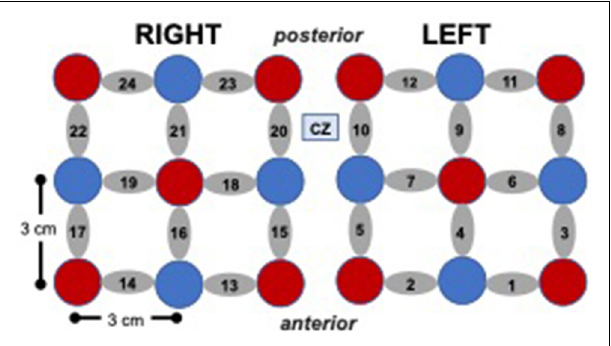
FIGURE 2 | Cap array, with red circles representing light sources, blue circles represent detectors, and gray ellipses representing